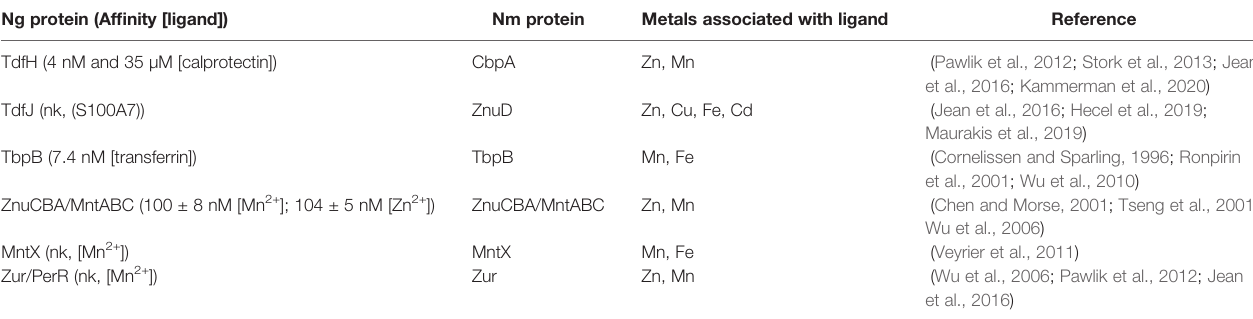
TABLE 1 | Neisseria gonorrhoeae (Ng) and Neisseria meningitidis (Nm) express proteins which are potentially involved in integrated metal